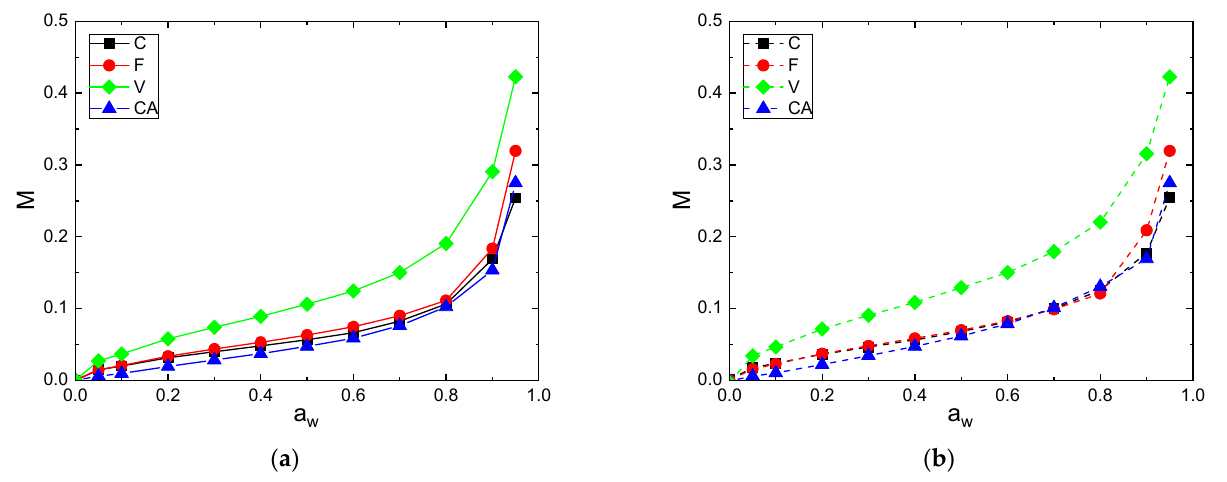
Figure 5. Water ( a ) sorption and ( b ) desorption of C, F, V and CA fibers.